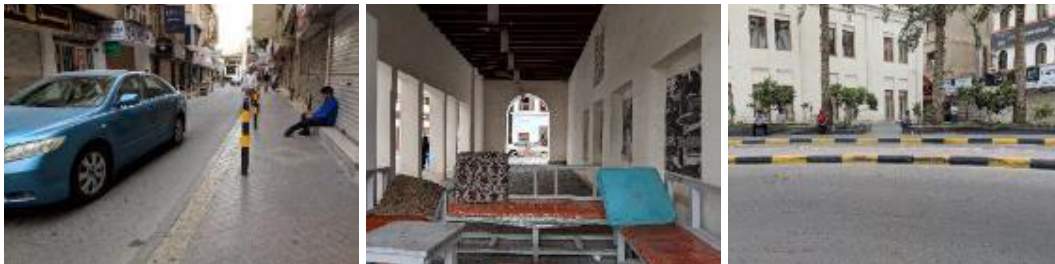
Figure 16. Sitting areas: more visual pollution sources in term of the clear haphazard in allocating for sitting areas.